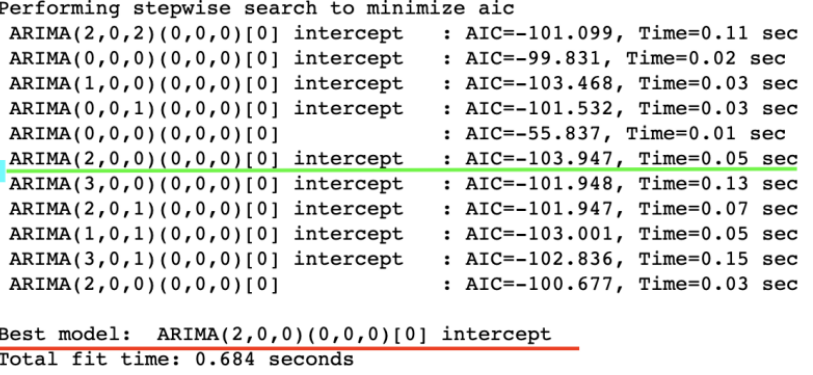
Figure 25. Step-wise AIC results using subscriber